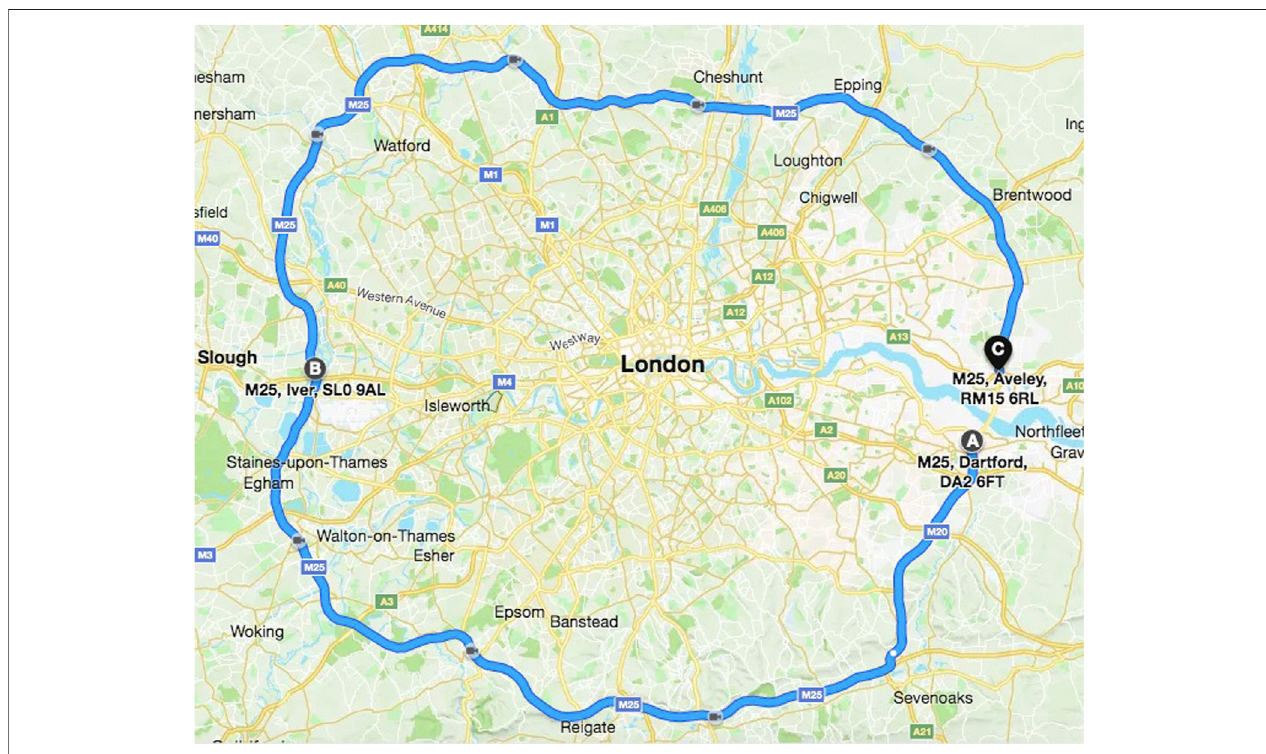
FIGURE 1 | The M25 London Orbital, roughly 180 km in length. The Dartford crossing, located in the east, is a short segment of road that is not included in the data set.